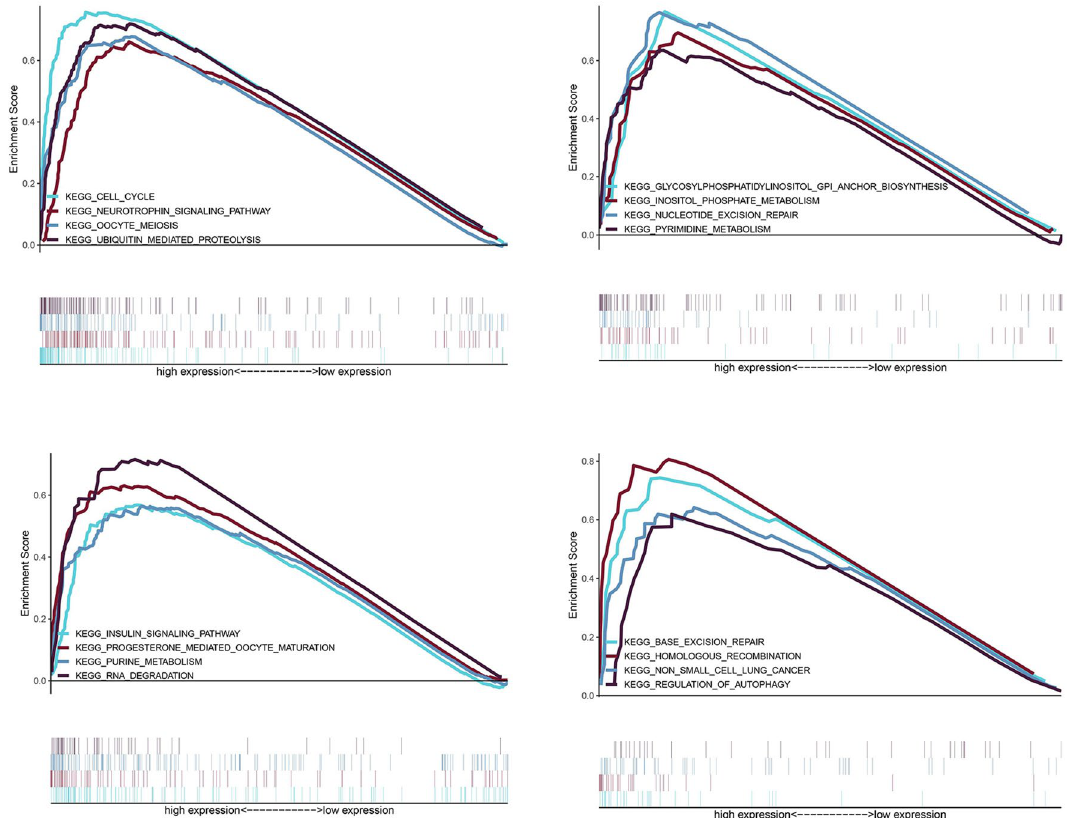
Figure 9. GSEA analysis, 16 KEGG pathways were significantly activated in high-risk